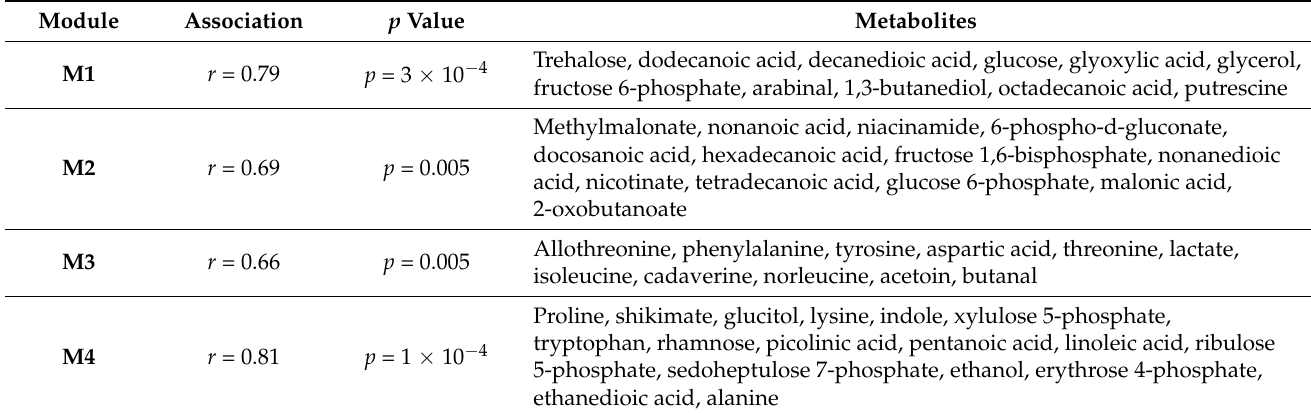
Figure 5. Heat map analysis of the metabolites identified in each distinct metabolic module of WGCNA analysis. ( A ) The metabolic module (M1) showed a highly positive association with DMSO; ( B , C ) the metabolic modules (M3 and M4) showed a highly positive association with sodium butyrate (SB); ( D ) the metabolic module (M4) showed a highly positive association with LaCl 3 . Table 1. Information of all of the distinct metabolic modules identified by WGCNA analysis.